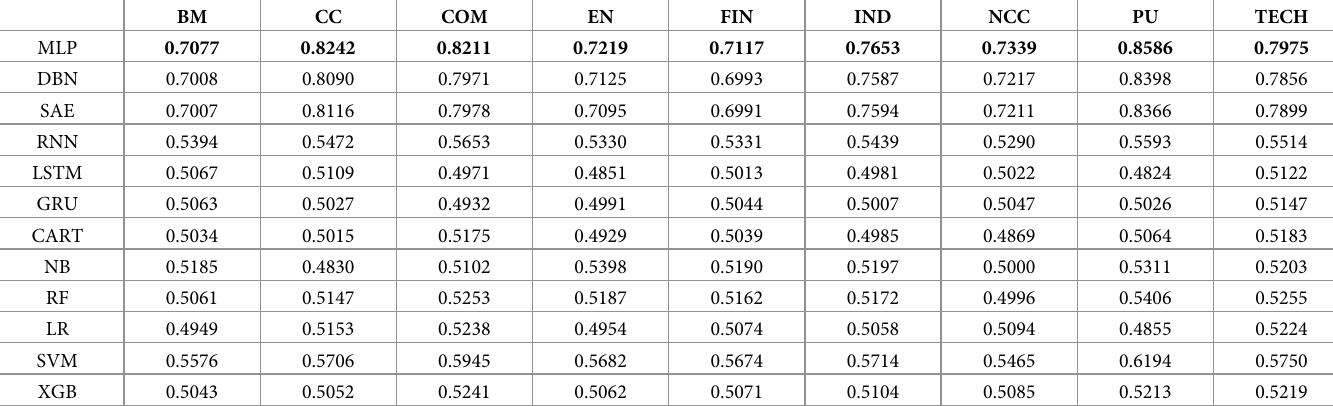
Table 8. Comparison of the WR of different trading algorithms in the different industries of CSICS. Best performance is in boldface. BM